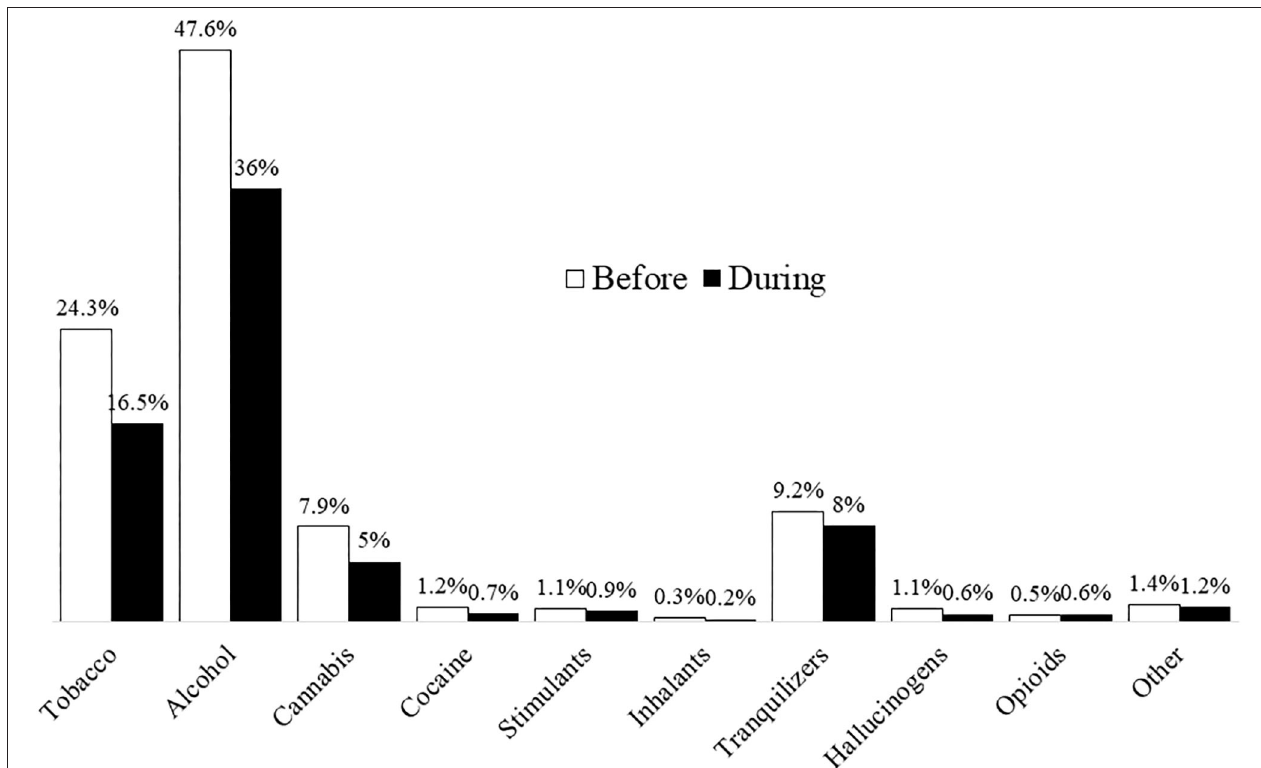
FIGURE 1 | Substance use before and during the quarantine.